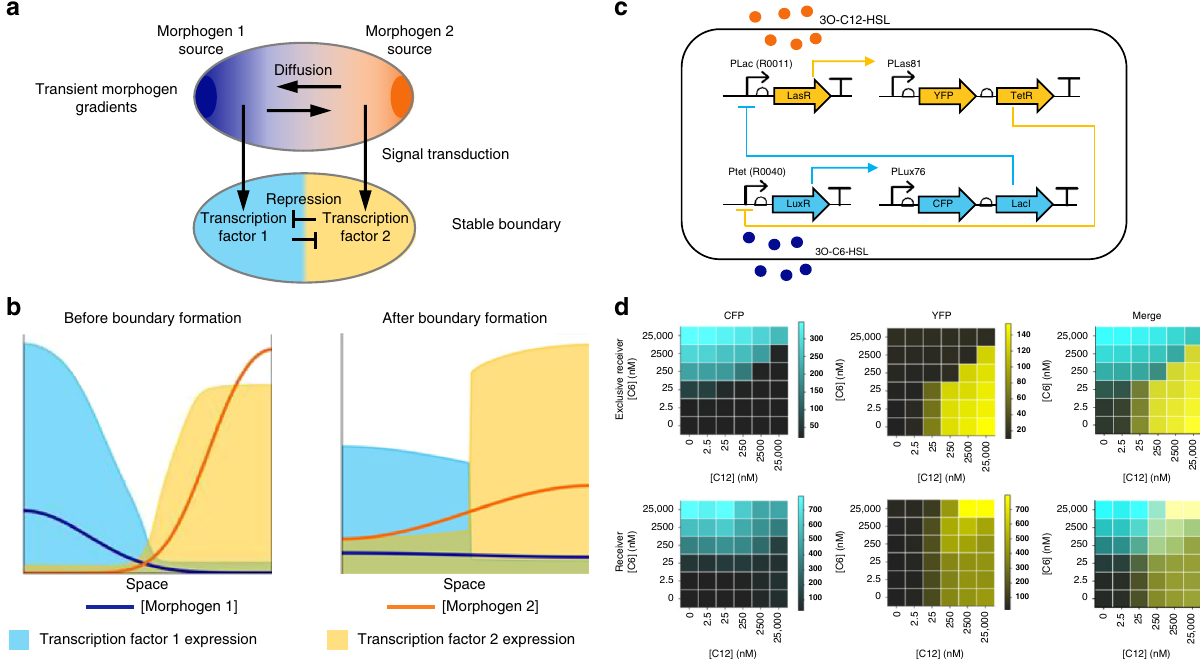
Fig. 1 A synthetic gene circuit for morphogen interpretation. a Schematic representation of a developing embryo. Mutual inhibition of transcription factors (cyan and yellow) downstream of antiparallel morphogen gradients (dark blue and orange) has been hypothesized to produce mutually exclusive domains of gene expression. b Morphogen gradients can be dynamic and transient, yet sharp, stable boundaries are observed between domains of gene expression. c A diagram of the Exclusive Receiver circuit. When 3O-C12-HSL (C12) levels are high, C12 binds to LasR, activating the expression of YFP and TetR, which represses the expression of LuxR, preventing expression of CFP and LacI. When 3O-C6-HSL (C6) levels are high, C6 binds to LuxR activating expression of CFP and LacI, which represses the expression of LasR, preventing expression of YFP and TetR. d Fluorescence output, measured in microplate fl uorometer assays, of the Exclusive Receiver (top) and the Receiver (bottom) circuits represented as a ratio of CFP- (left) or YFP- (right) fl uorescence to RFP fl uorescence during exponential phase 38 , cultured in the presence of the concentrations of C6 and C12 indicated. Data are representative of n = 3 biological replicate experiments conducted on different days. See Supplementary Figs. 11 and 12 for replicates. Source data are provided as a Source Data fi